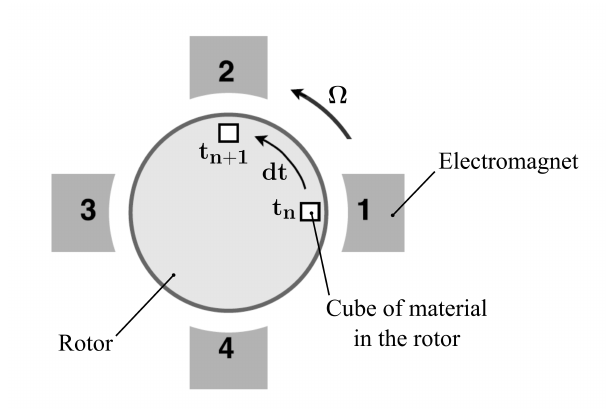
Figure 10. Schematic of the spinning